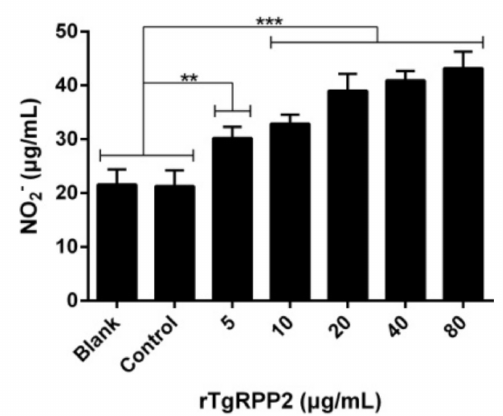
Figure 6. Effect of rTgRPP2 on the NO production of murine Ana-1 cells. Through treatment with different concentrations of rTgRPP2 for 48 h, the NO concentrations were determined. Values were evaluated using one-way ANOVA analysis, followed by Dunnett’s test, and presented as the mean ± standard deviation of three independent experiments ( n = 3). ** p < 0.01 and *** p < 0.001 compared with the blank group or the control